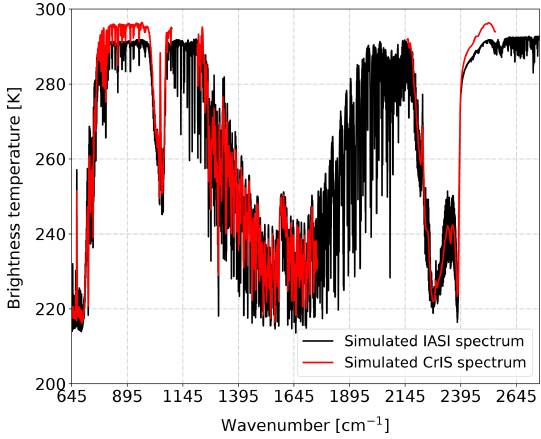
Figure 8. Brightness temperature spectrum of simulated IASI (in black) and CrIS (in blue) observations w.r.t. wavenumbers using O 3 , CO 2 and CH 4 reference profiles for in situ sounding from 17 April 2018 at